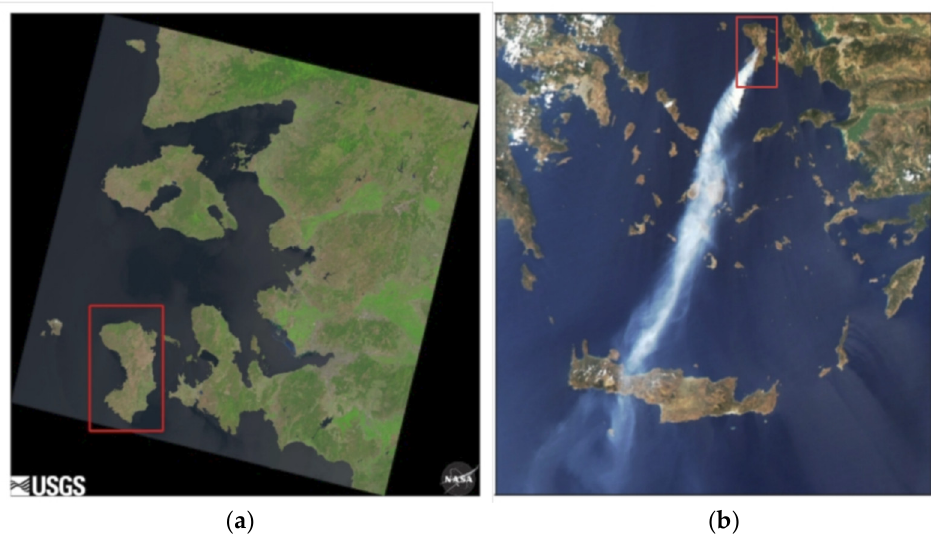
Figure 4. The study area in a Landsat-8 scene acquired on 13 July 2016 used in this study and the area of interest in the bounding box ( a ); the smoke plume dispersing over the Aegean sea from a historic fire that occurred in on Chios captured by the MODIS sensor on NASA’s AQUA satellite Aqua on 18 th August 2012 ( b ).